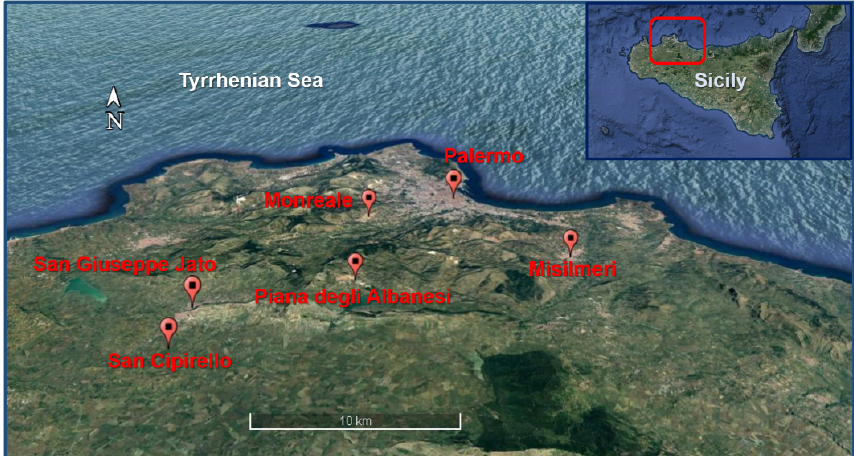
Figure 21. Map showing six weather stations on the northwestern part of Sicily (edited from Google